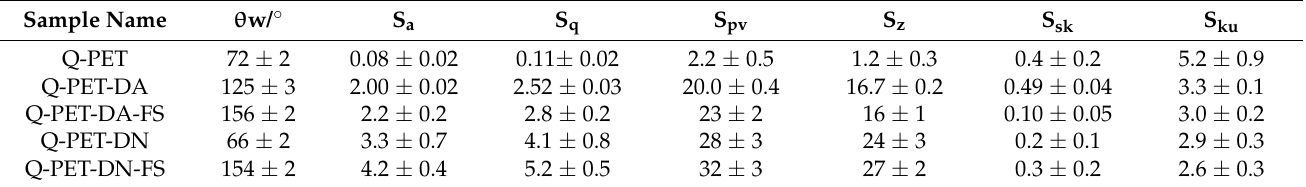
Table 2. Water contact angles, θ w, and roughness parameters determined by optical